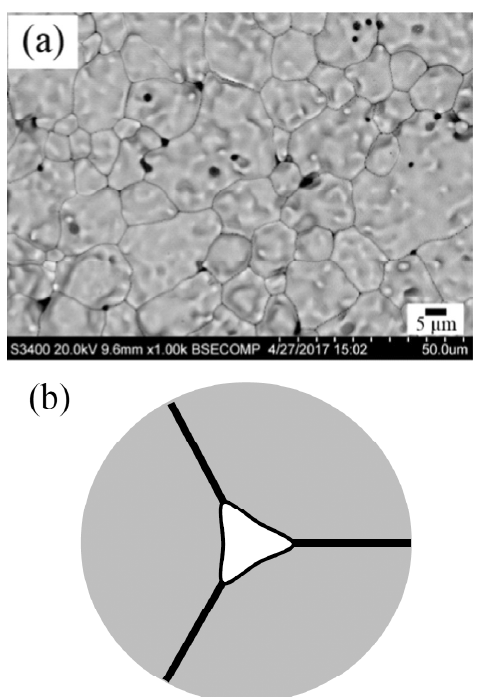
Fig. 1. (a) An example of intra- and intergranular porosity in 12CaO-88ZrO (12CSZ, mol.%) cera- 2 mics [28]; @ Elsevier, with permission. Most of the intergranular pores are of nearly triangular shape and are located at triple junctions of grain bounda- ries. (b) Sketch of an idealized triple-fold symmetry pore in such a triple